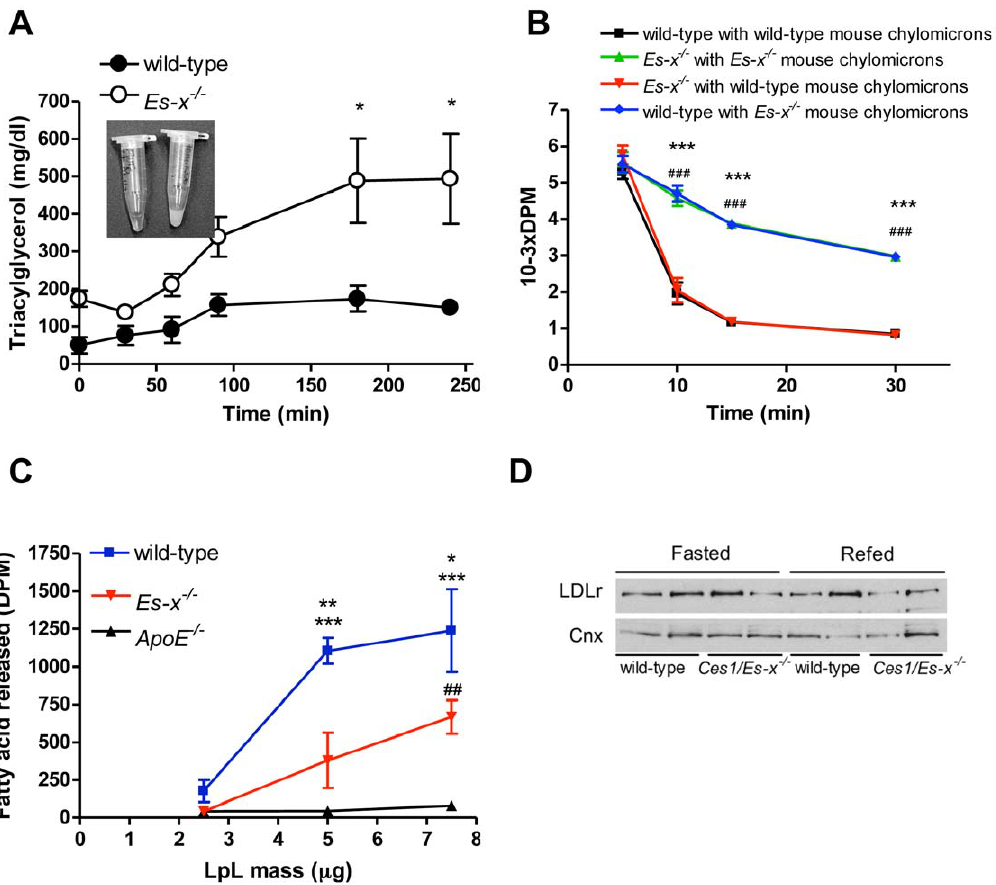
Figure 2. Impaired chylomicron clearance in Ces1/Es-x 2 / 2 mice. (A) Fat tolerance test in 12-h fasted mice. Mice were gavaged with 150 m l olive oil. Blood samples were collected at the indicated times, plasma was prepared and TG concentrations were measured by gas chromatography. N=4– 6 mice/group. Inset shows plasma appearance 4 h after the lipid load (wild-type on the left and Ces1/Es-x 2 / 2 on the right). *p , 0.05 vs. wild-type. (B) Chylomicron clearance. Labeled chylomicrons were isolated from plasma of wild-type and Ces1/Es-x 2 / 2 mice and injected into abdominal veins of mice of both genotypes. Blood samples were collected, plasma prepared and radioactivity measured by scintillation counting. N=6 mice/group. ***p , 0.001 black line vs. blue line, ### p , 0.001 green line vs. red line. (C) In vitro lipolysis of chylomicrons from wild-type, Ces1/Es-x 2 / 2 and ApoE 2 / 2 mice by isolated LpL. N=3 mice/group. Details about the procedure are given in the main text. *p , 0.05 vs. Es-x 2 / 2 , **p , 0.01 vs. Es-x 2 / 2 ; ***p , 0.001 vs. ApoE 2 / 2 , ## p , 0.01 vs. ApoE 2 / 2 . (D) Immunobotting showing hepatic LDLr protein expression from fasted and re-fed (6 h)